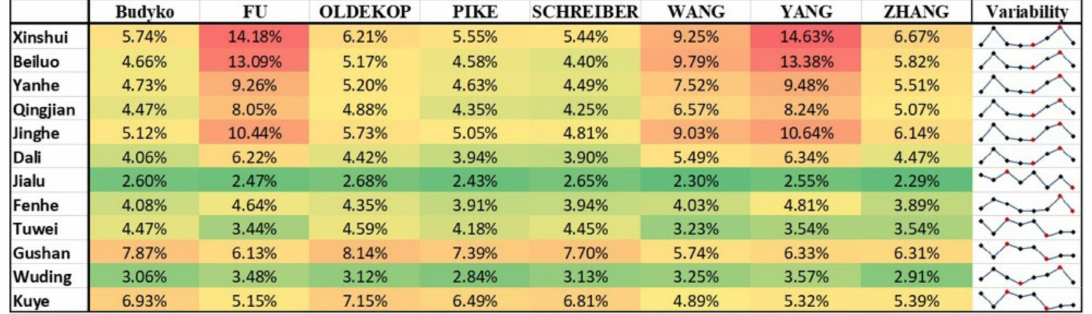
Figure A5. Standard deviation of quantitative contribution to streamflow change calculated by fixed Budyko-based methods and varied E 0